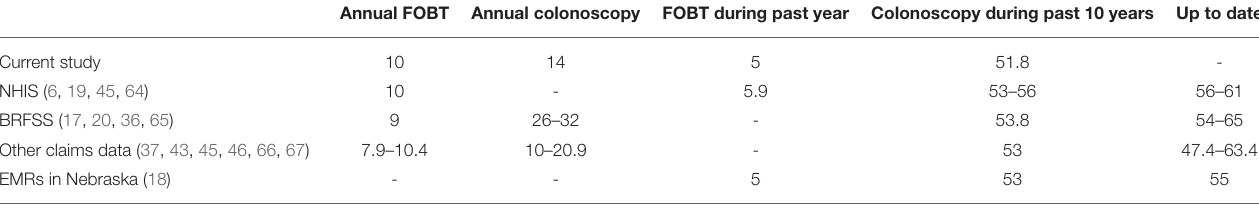
TABLE 5 | Comparison of CRC screening with national and state data